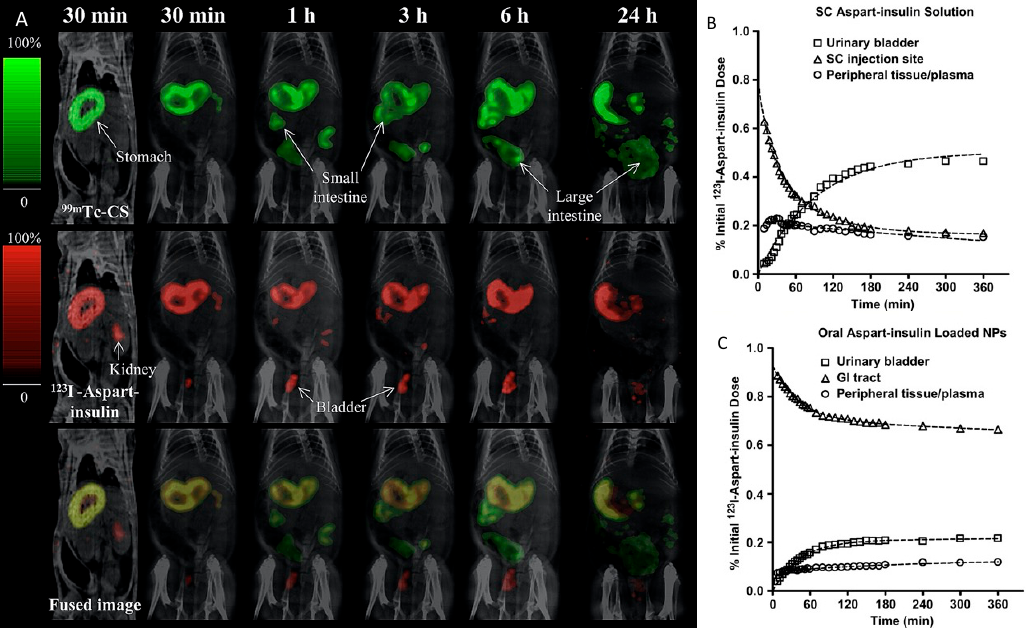
Figure 8. ( A ) Oral biodistribution of 99m Tc-labeled-chitosan nanoparticles (green) containing 123 I-labeled aspart-insulin (red) using SPECT/CT imaging in a rat model. Percentage dose of aspart-insulin observed over time in the urinary bladder, injection site/GI tract, and peripheral tissue/plasma after ( B ) subcutaneous injection and ( C ) oral gavage in rats. Reprinted with permission from Sonaje et al. (2010) [55].